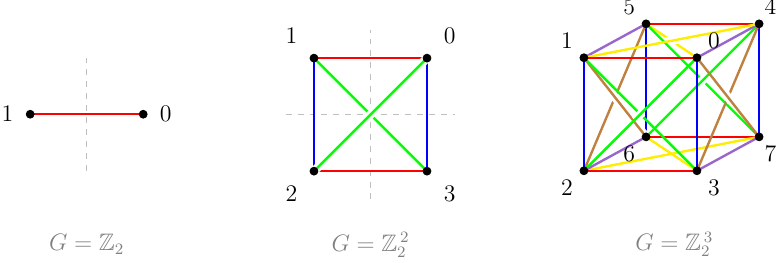
Figure 4. The (cid:12)rst three instances of maximally symmetrical interaction vertices, with q = 2 v and G = Z v . We omitted one color from the q = 8 case, namely a seventh color with edges running 2 from each corner to the diametrically opposite corner, for example from 0 to